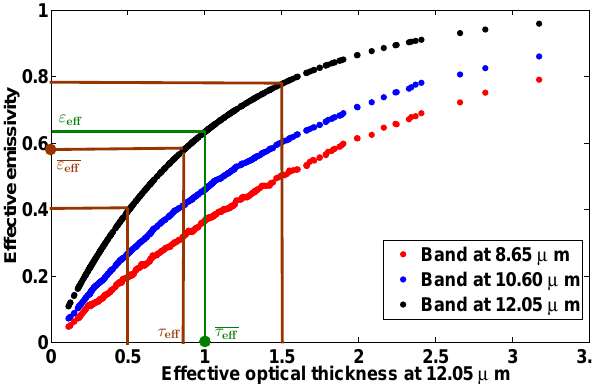
Figure 4. Variation of the effective emissivity as a function of the effective optical thickness at 12.05µm, estimated in 1-D at the spa- tial resolution of 100m for the three IIR channels and for cloudy pixels belonging to cirrus cases 1 to 5. τ eff represents the effective optical thickness corresponding to the averaged effective emissiv- ity ε eff , τ eff represents the averaged effective optical thickness and ε eff is its corresponding effective emissivity. Brown and green lines show the effective emissivity and effective optical thickness values on the x axis and y axis, respectively, corresponding to a particular point on, for instance, the black arch. The mathematical formulation of the PPA is expressed by the Jensen inequality ε eff < ε eff (τ eff )